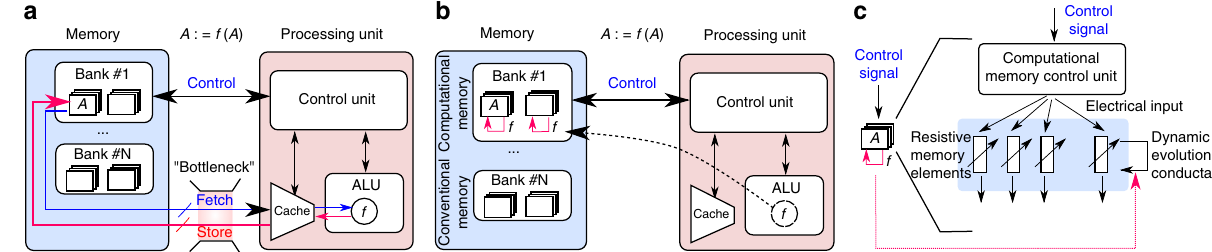
Fig. 1 The concept of computational memory. a Schematic of the von Neumann computer architecture, where the memory and computing units are physically separated. A denotes information stored in a memory location. To perform a computational operation, f ( A ), and to store the result in the same memory location, data is shuttled back and forth between the memory and the processing unit. b An alternative architecture where f ( A ) is performed in place in the same memory location. c One way to realize computational memory is by relying on the state dynamics of a large collection of memristive devices. Depending on the operation to be performed, a suitable electrical signal is applied to the memory devices. The conductance of the devices evolves in accordance with the electrical input, and the result of the operation can be retrieved by reading the conductance at an appropriate time